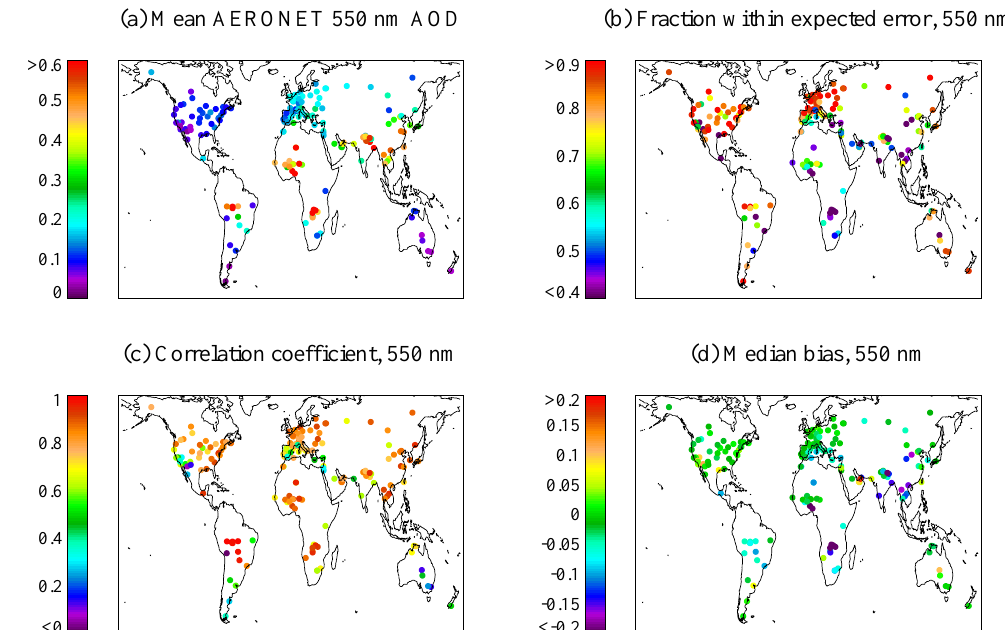
Fig. 7. Statistics related to AERONET 550nm AOD comparison at each site considered: (a) mean AERONET AOD; (b) fraction of com- parisons within the expected error (0.05+0.2 τ A,550 ); (c) Pearson’s linear correlation coefficient between the matched data; and (d) median (SeaWiFS-AERONET) AOD